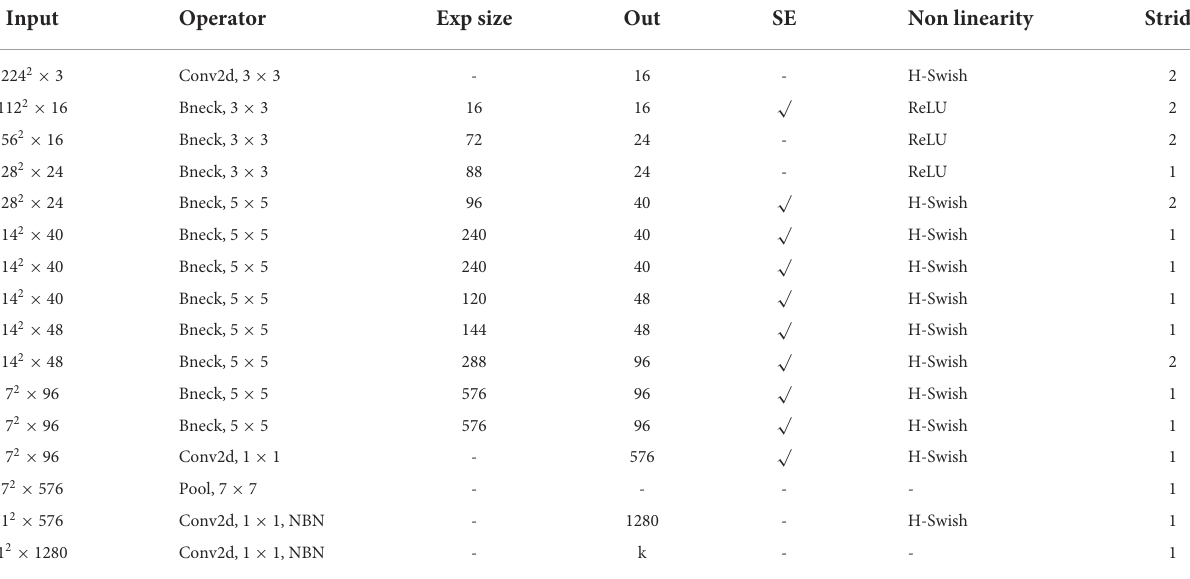
TABLE 2 Specification for